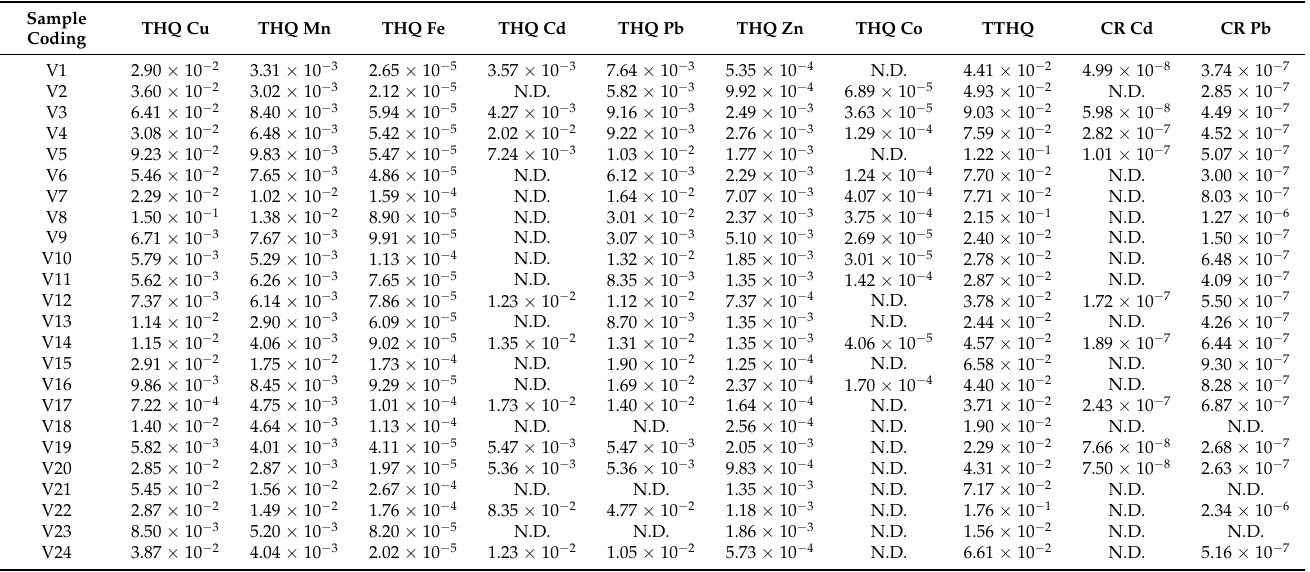
Table 4. Obtained results for the target hazard quotient (THQ), the total of the target hazard quotient (TTHQ) and the carcinogenic risk (CR) in the case of vegetable samples.